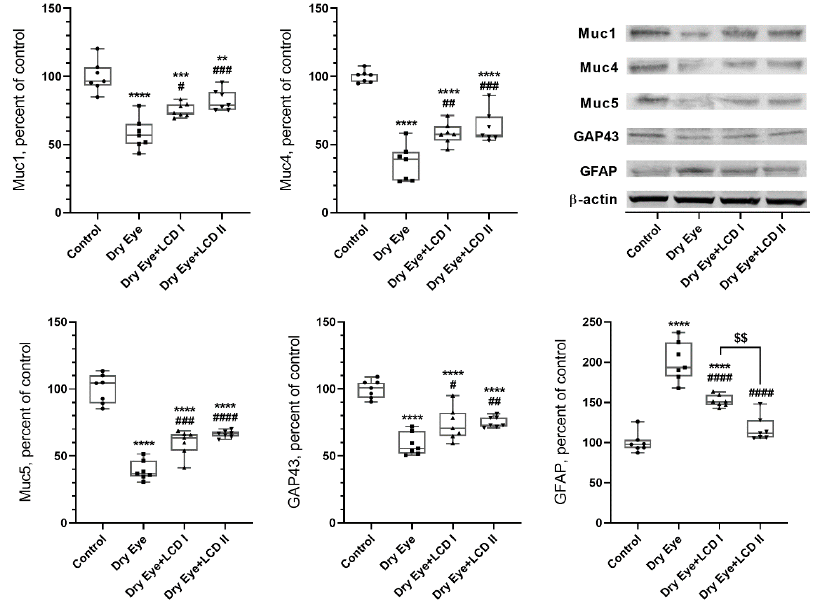
Figure 6. Effect of the combination of lutein/zeaxanthin, curcumin and vit D (LCD) on Muc1, Muc4, Muc5, growth-associated protein 43 (GAP43), and glial fibrillary acid protein (GFAP) benzalkonium chloride (BAC)-induced dry eye syndrome in rats. ( n = 7 per group). Control: No treatment; Dry Eye: BAC-induced dry eye syndrome; LCD I; Dry Eye + LCD I: BAC-induced dry eye syndrome plus LCD I (100 mg/kg body weight); Dry Eye + LCD II: BAC-induced dry eye syndrome plus LCD II (200 mg/kg body weight). Data are expressed as percent of the control value. Western blot analysis (n = 3 at least) was performed with actin included to ensure equal protein loading. (ANOVA and Tukey ′ s post-hoc test. Statistical significance between groups is shown by: ** p < 0.01; *** p < 0.001; **** p < 0.0001 compared as control group; # p < 0.05; ## p < 0.01; ### p < 0.001; #### p < 0.0001 compared as Dry Eye group; $$ p < 0.01 compared as Dry Eye + LCD I group).